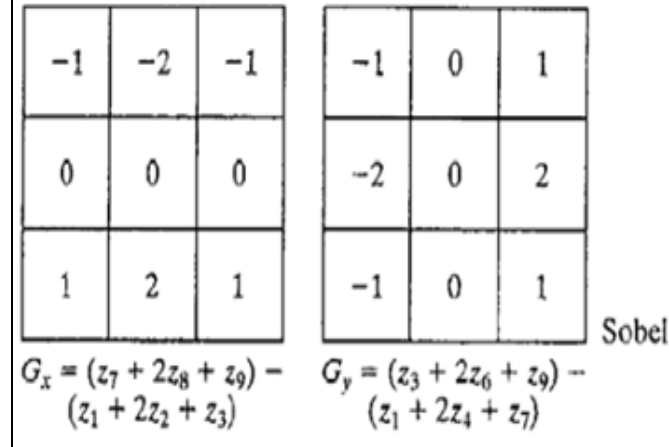
Figura 14: Mascara detectora de bordes y su derivada de primer orden que